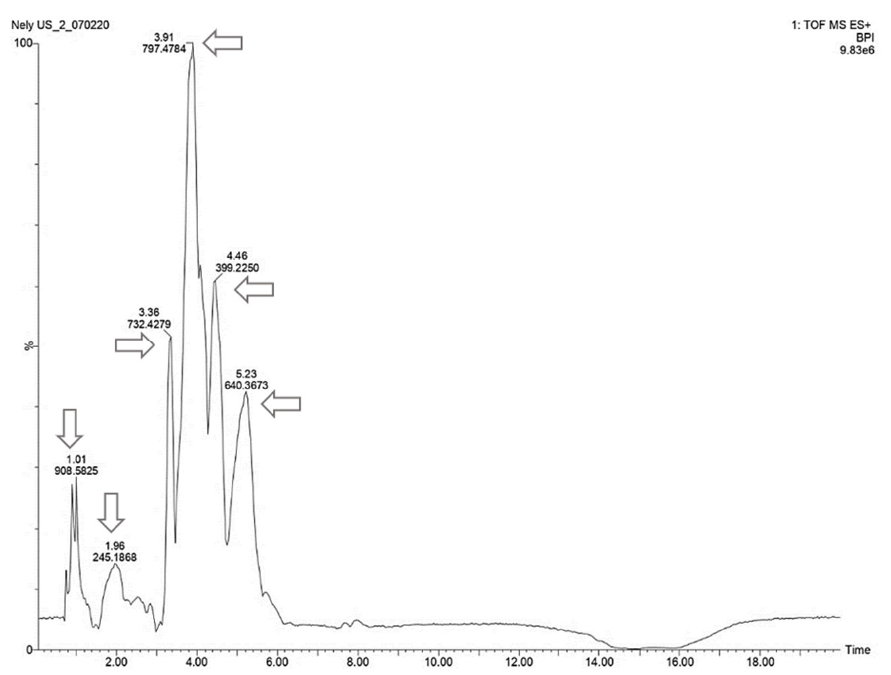
Figure 6. Mass spectrum (HILIC-ESI-QTOF-MS) of chicken feather keratin hydrolyzate composed of ultrasound and enzymatic steps.